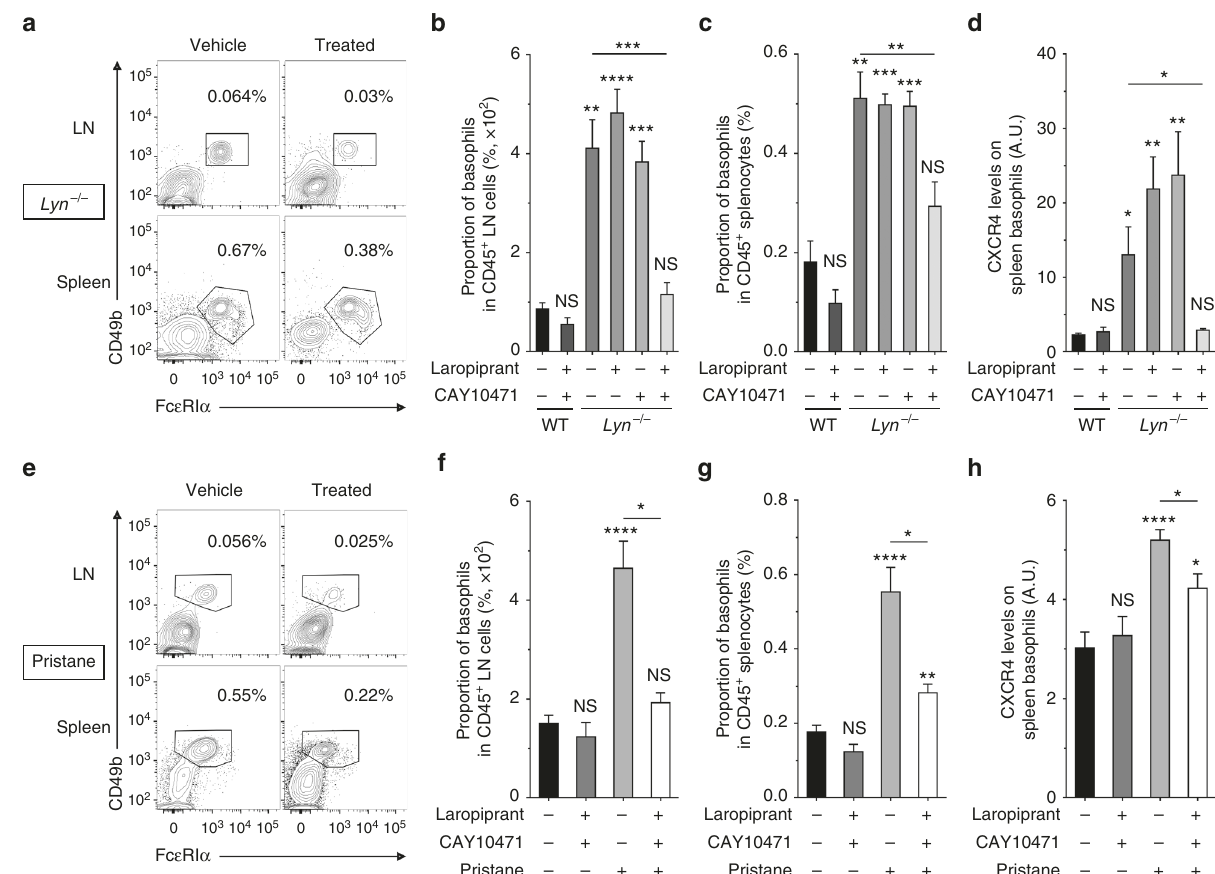
Fig. 6 PTGDR blockade dampens basophil accumulation in SLO in a lupus environment. a , e Representative contour plots of basophils among living CD45 + cells in LN and spleen from aged Lyn – / – mice ( a ) and pristane-injected WT mice ( e ) treated or not (vehicle) with both PTGDR-1 and PTGDR-2 antagonists for 10 days. Proportions are shown on the plots. b − d Comparisons between aged wild-type (WT) treated ( n = 4) or not ( n = 5) with both PTGDR antagonists and aged Lyn – / – mice treated or not ( n = 12) with Laropiprant ( n = 5), CAY10471 ( n = 4), or both antagonists ( n = 9). b , c Proportion of basophils among living CD45 + cells in LN ( b ) and spleen ( c ). d CXCR4 expression on spleen basophils in mice as in ( c ). f – h Comparisons between aged WT mice 24 weeks after injection of either PBS or pristane and treated or not with both PTGDR antagonists (from left to right: n = 12/4/9/4). f , g Proportion of basophils among living CD45 + cells in LN ( f ) and spleen ( g ). h CXCR4 expression on spleen basophils in mice as in ( f ). b – d , f – h Data were determined by fl ow cytometry as described in Supplementary Fig. 4a – c and represent two pooled independent experiments for each model. Data are presented as mean ± s.e.m. Statistical analyses were by unpaired Student t tests. NS: not signi fi cant, * P < 0.05, ** P < 0.01, *** P < 0.001, **** P < 0.0001. Comparison to control group is shown above each bar and to the corresponding bars when indicated. A.U. arbitrary